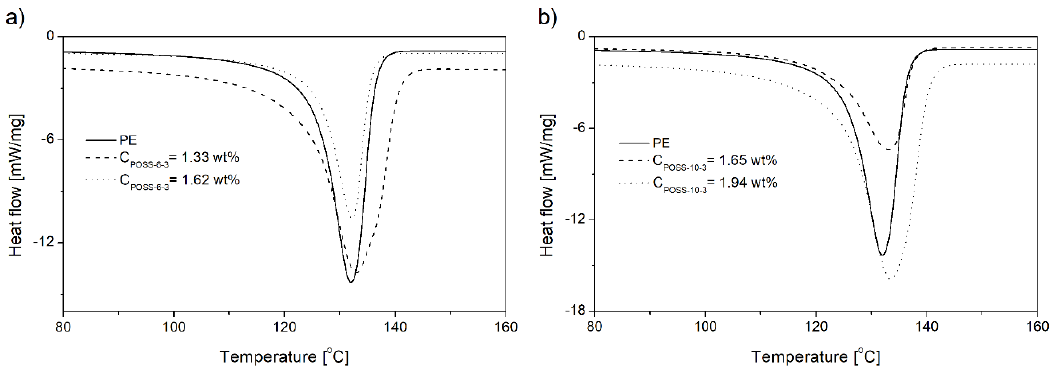
Figure 13. DSC curves of neat polyethylene and E/POSS copolymers synthesized by rac -Et(Ind) 2 ZrCl 2 (p e = 0.5 MPa) ( a , b ).